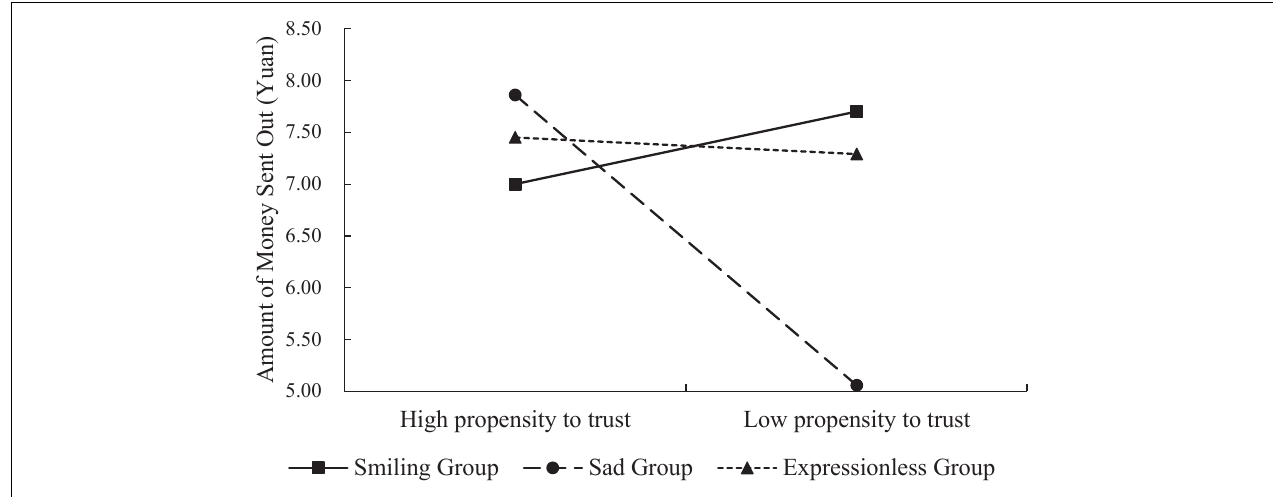
FIGURE 5 | Interaction between emojis and propensity to trust in relation to interpersonal trust.